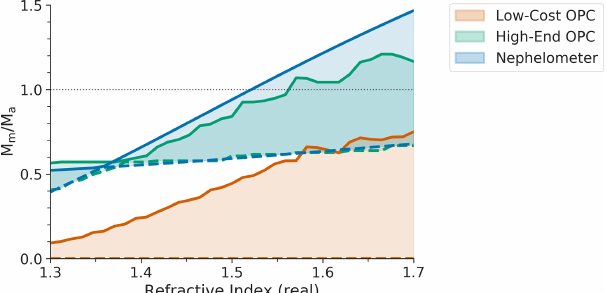
Figure 4. The accuracy of OPSs as a function of the refractive index of the aerosol being measured. The real component of the RI is on the x axis, and the width of each swatch is bounded by the absorp- tion and imaginary component, which spans from 0 (non-absorbing, solid line) to 0.79 (black carbon, dashed line). Results are shown for a nephelometer (blue) and the two OPCs (orange and green). All results are for a generic particle size distribution with number- weighted GM = 200nm and GSD = 1.65, and the OPSs were cali- brated with